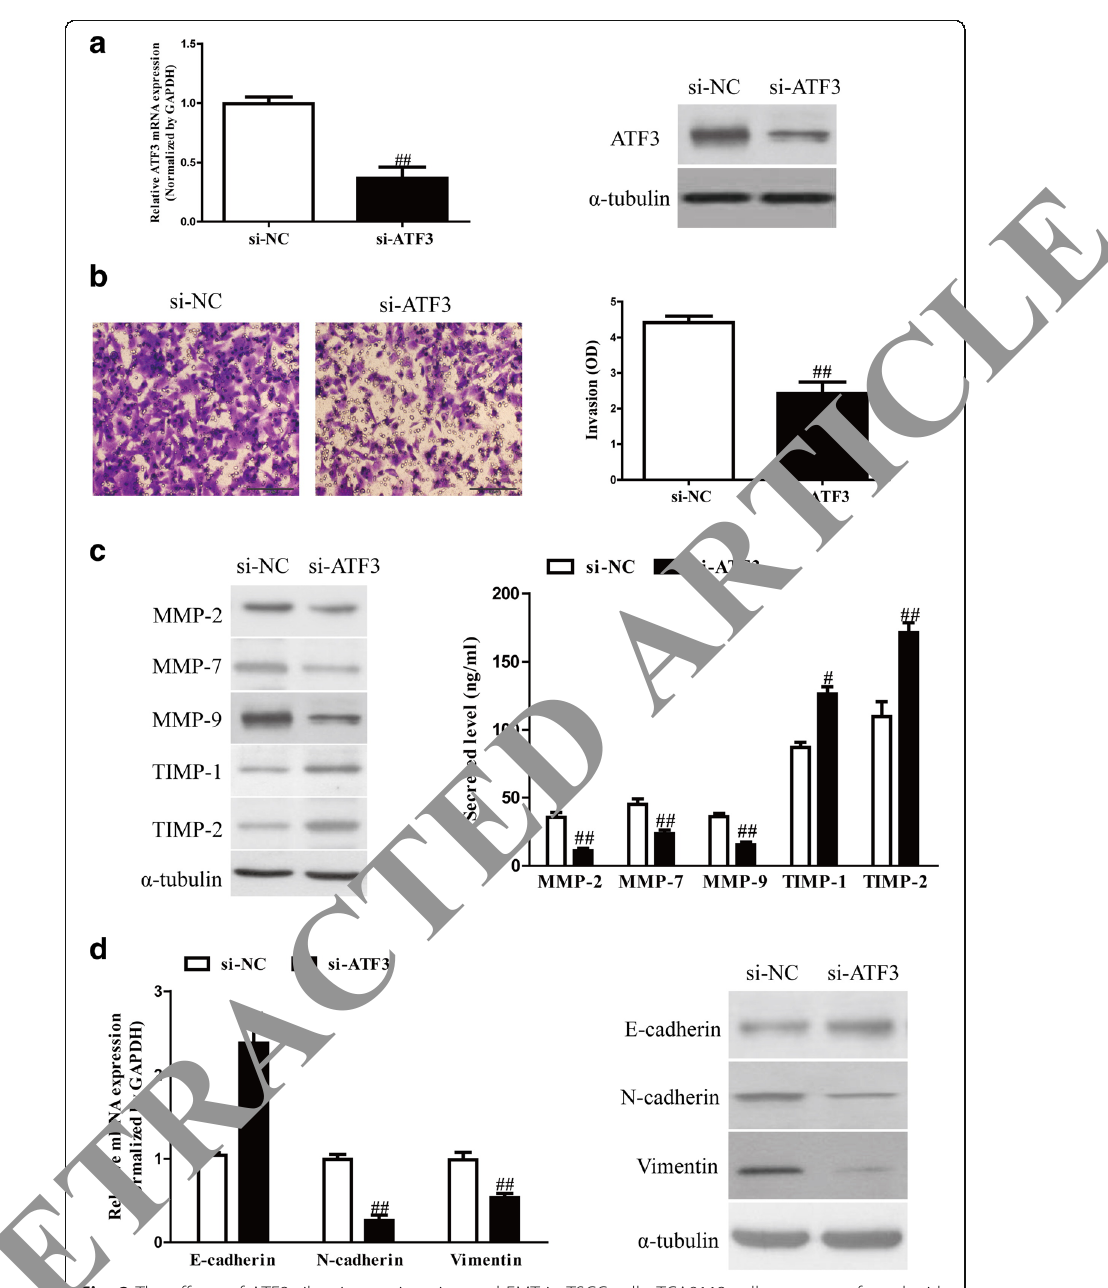
Fig. 2 The effects of ATF3 silencing on invasion and EMT in TSCC cells. TCA8113 cells were transfected with si-ATF3 or si-NC. a The mRNA and protein expressions of ATF3 were determined via quantitative RT-PCR and western blot, respectively. b Invasion was assessed via transwell assay. c The protein expressions of MMP-2, MMP-7 MMP-9, TIMP-1 and TIMP-2 were assessed via western blot and ELISA assays. d The expressions of E-cadherin, N-cadherin and vimentin were determined via quantitative RT-PCR and western blot assays, respectively. All data are presented as means ± SEM, n =6. # p <0.05, ## p <0.01 vs.